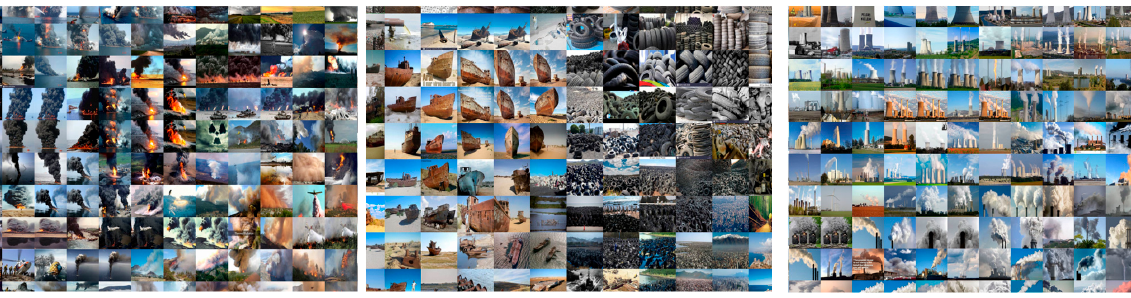
Figure 19. Climate change map detail. © Pilar